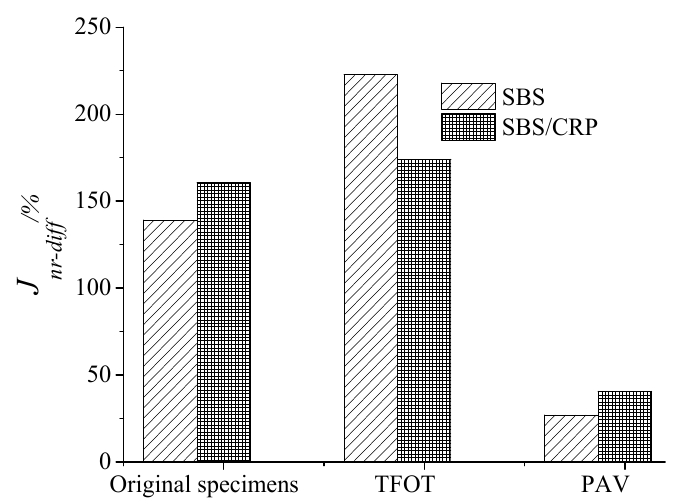
Figure 6. J nr-di ff of three asphalts in di ff erent aging Figure 6. J nr-diff of three asphalts in different aging treatments.